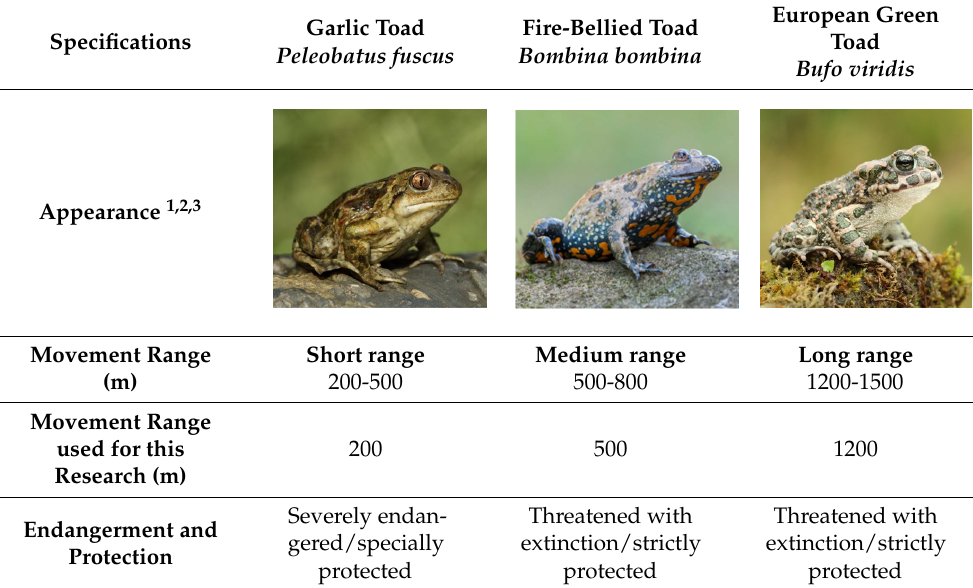
cially protected